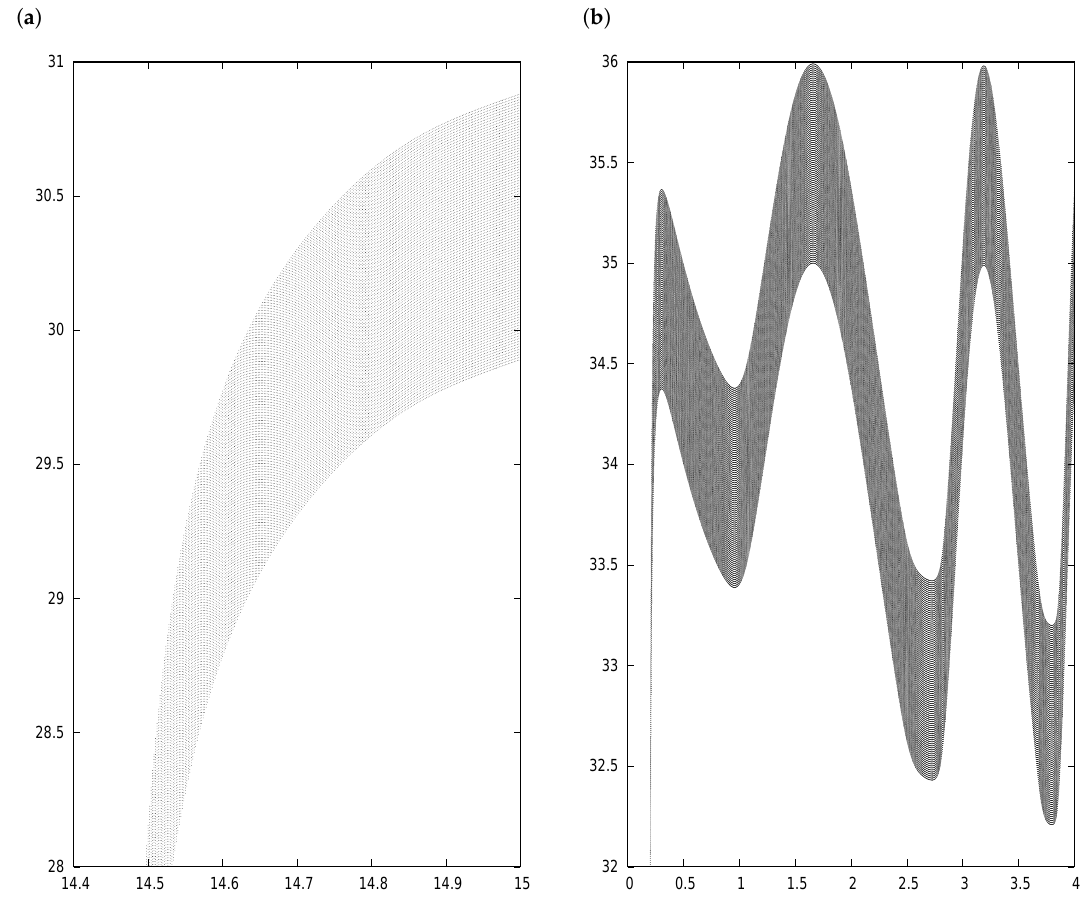
= 0.017. Figure 3. Bifurcation diagrams of modified system (1) with ( a ) c = 1.7, ( b ) d = 5 an initial condition 0